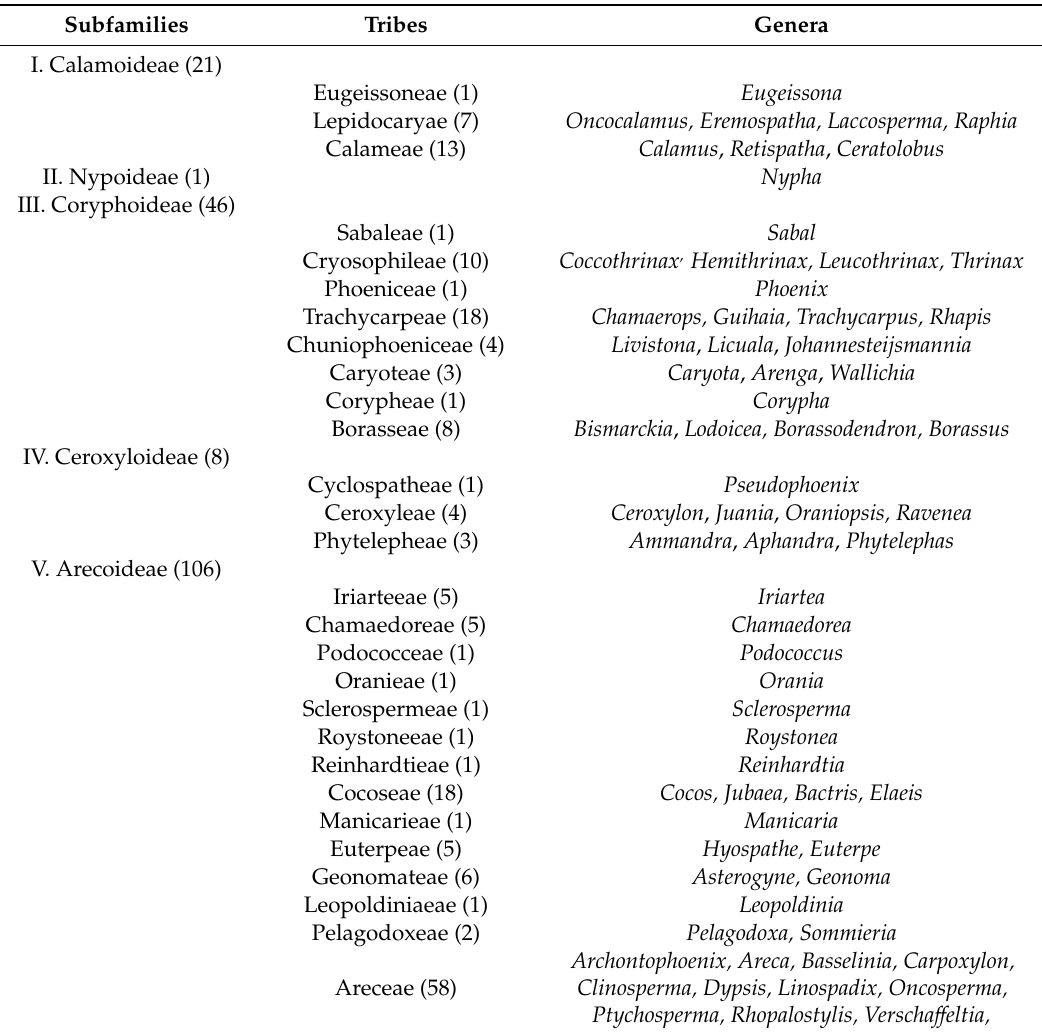
Table 1. A summary of the taxonomy of the Arecaceae. Subfamilies Calamoideae, Nypoideae, Coryphoideae, Ceroxyloideae, and Arecoideae divided into tribes. The number of genera in each subfamily and tribe is given between parentheses. Some examples of genera in each of the tribes are shown. Data adapted from